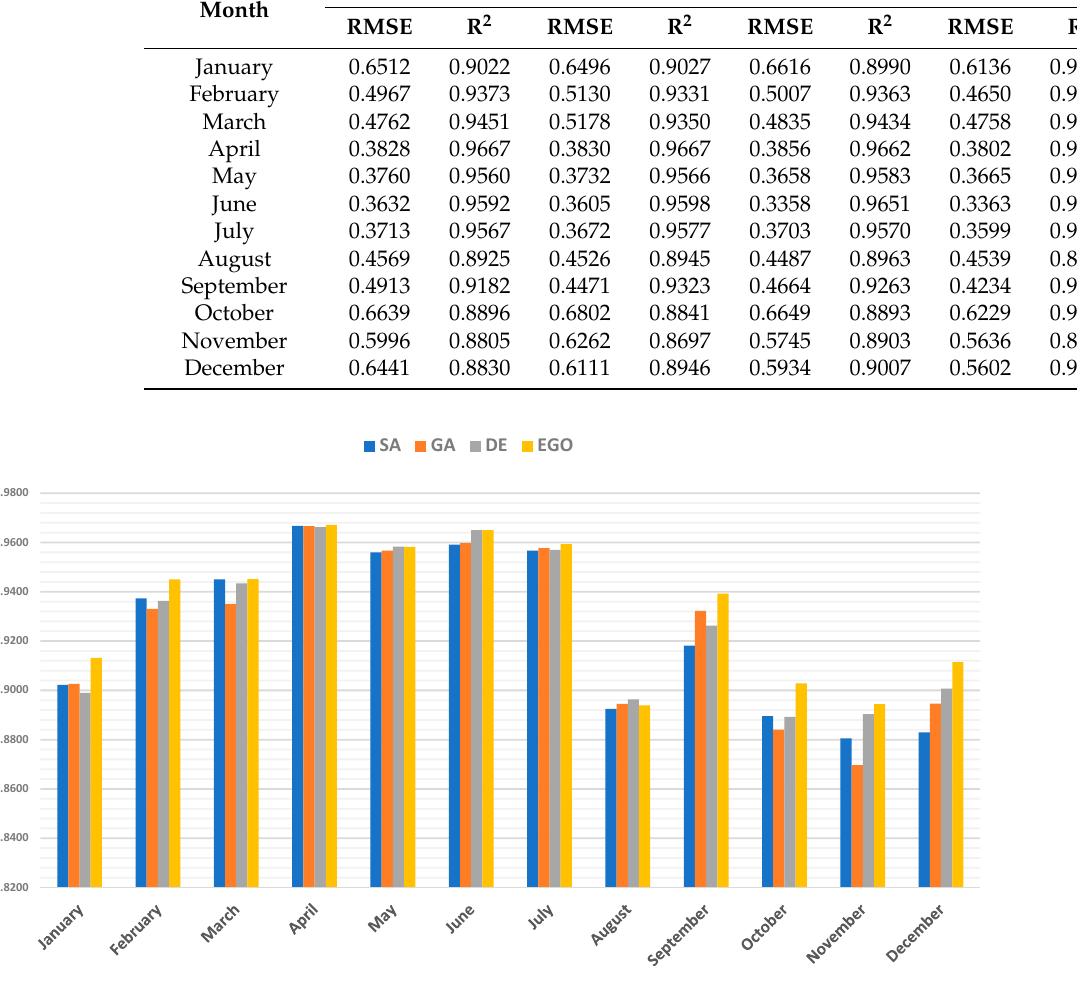
Figure 11. RMSE values for monthly parameter estimation per each technique (own elaboration). RMSE is also one of the most common metrics to compare the techniques for distri- bution fitting; the smaller the value of RMSE the better the performance of estimation. Figure 11 shows that RMSE calculated for estimations based on EGO is lower than others for most of the months. Table 6 shows estimated value of shape ( k ) and scale ( c ) parame- ters of the TPWD for annual data using four different techniques. Figure 12 represents the histogram of observed wind speed and the estimated TPWD obtained using four tech- niques for annual data. From both Table 6 and Figure 12, it can be concluded that there are no huge differences between the parameters estimated using the four different tech- niques. Table 6 also shows the performance of techniques based on two different metrics: RMSE and R 2 . From Table 6 and Figure 13, it can be seen that EGO provides the lowest RMSE and the highest R 2 . In other words, EGO has the best performance among other techniques for estimating the parameters of TWPD for annual data.